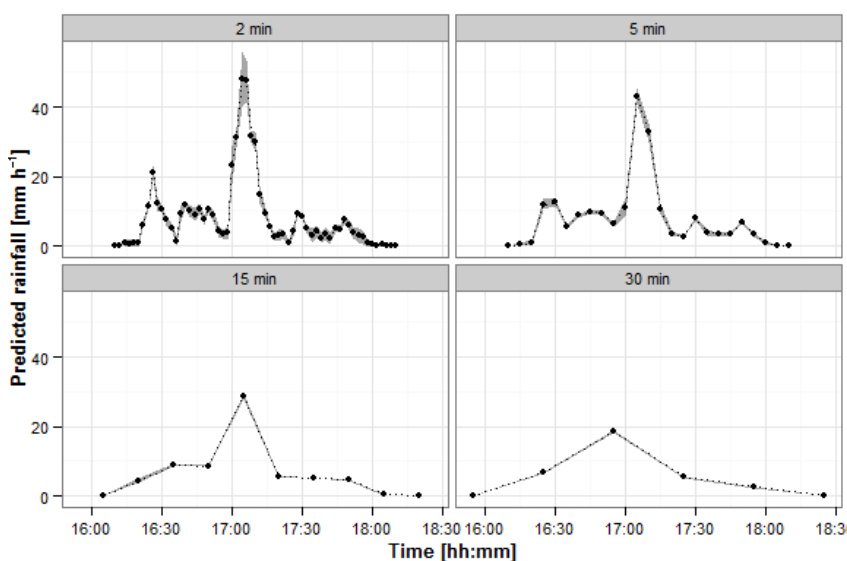
Figure 10. Predictions of AARI (indicated by points) together with 95% prediction intervals (indicated by grey ribbon) for rainfall event 11 for different averaging intervals.